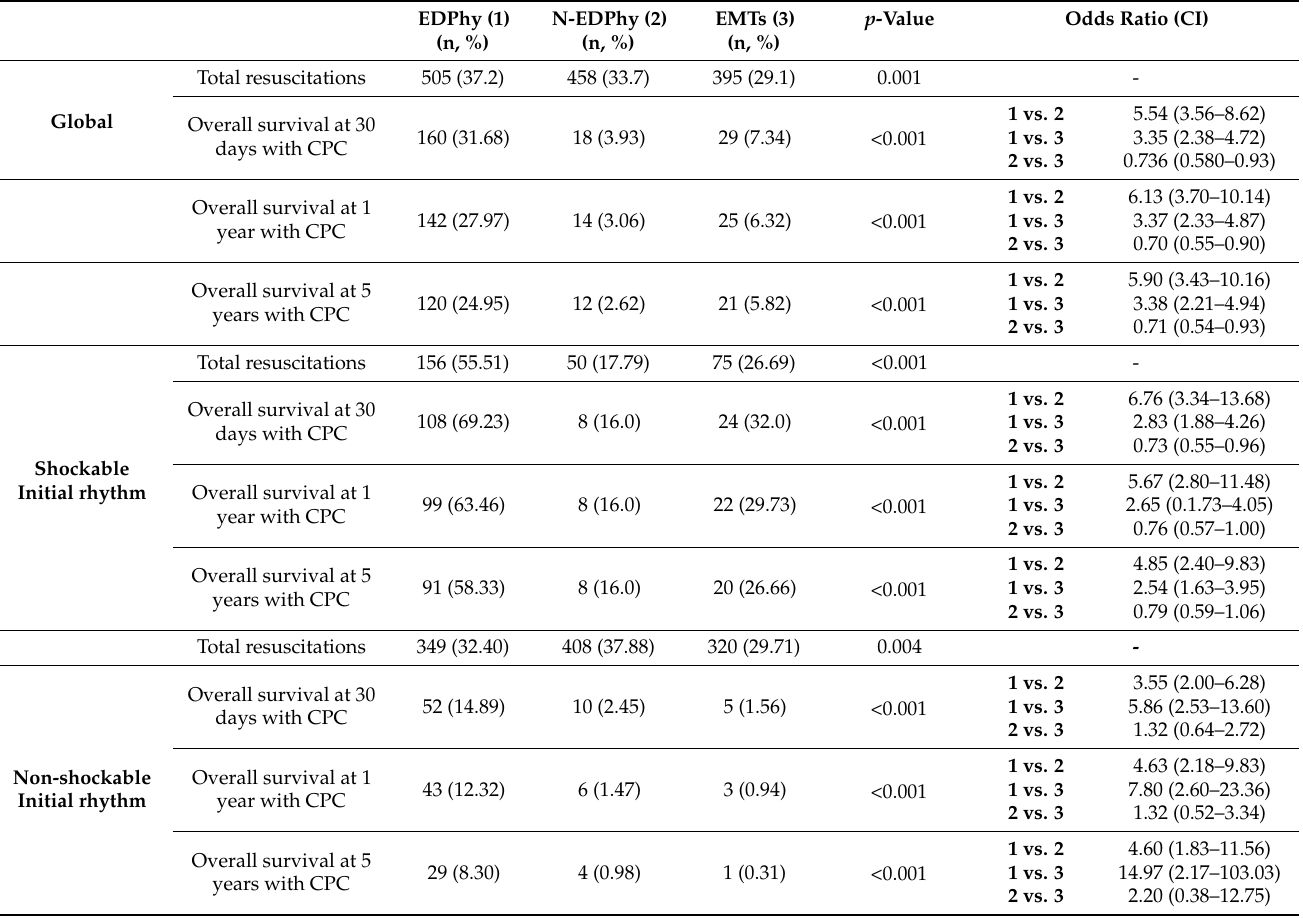
Table 3. Survival of the sample and cerebral performance category (CPC, 1-2) of the event based on the EMS that attends it and the initial